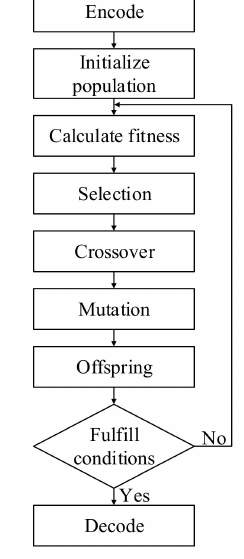
Figure 2. The flow chart of the genetic